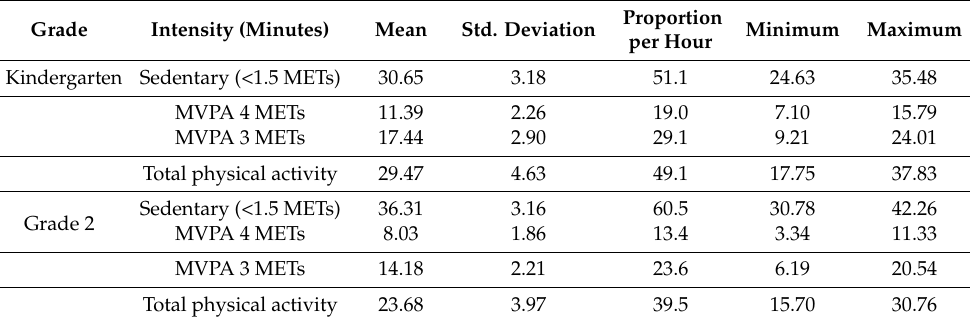
Proportion Minimum Maximum per Hour